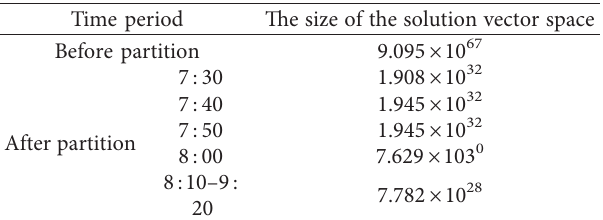
Table 7: The size of the solution vector space before and after partition. Time period Before